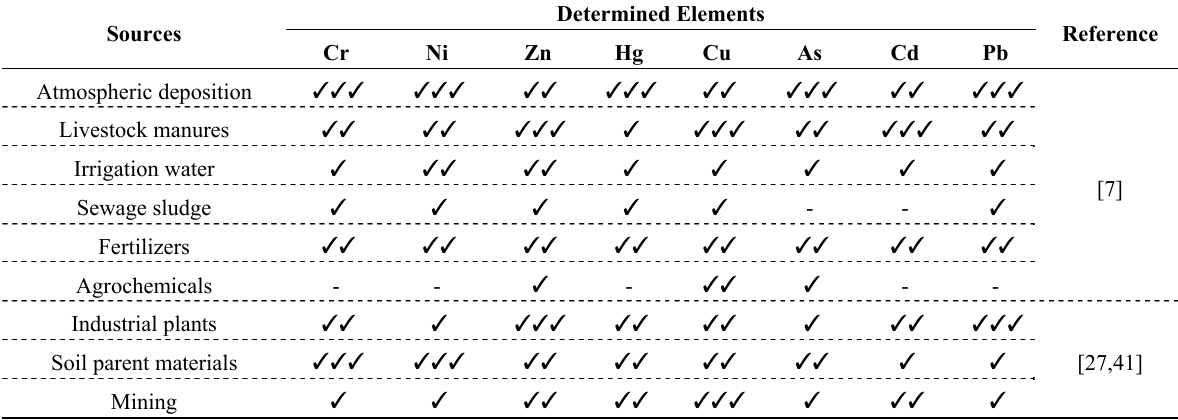
Industrial plants